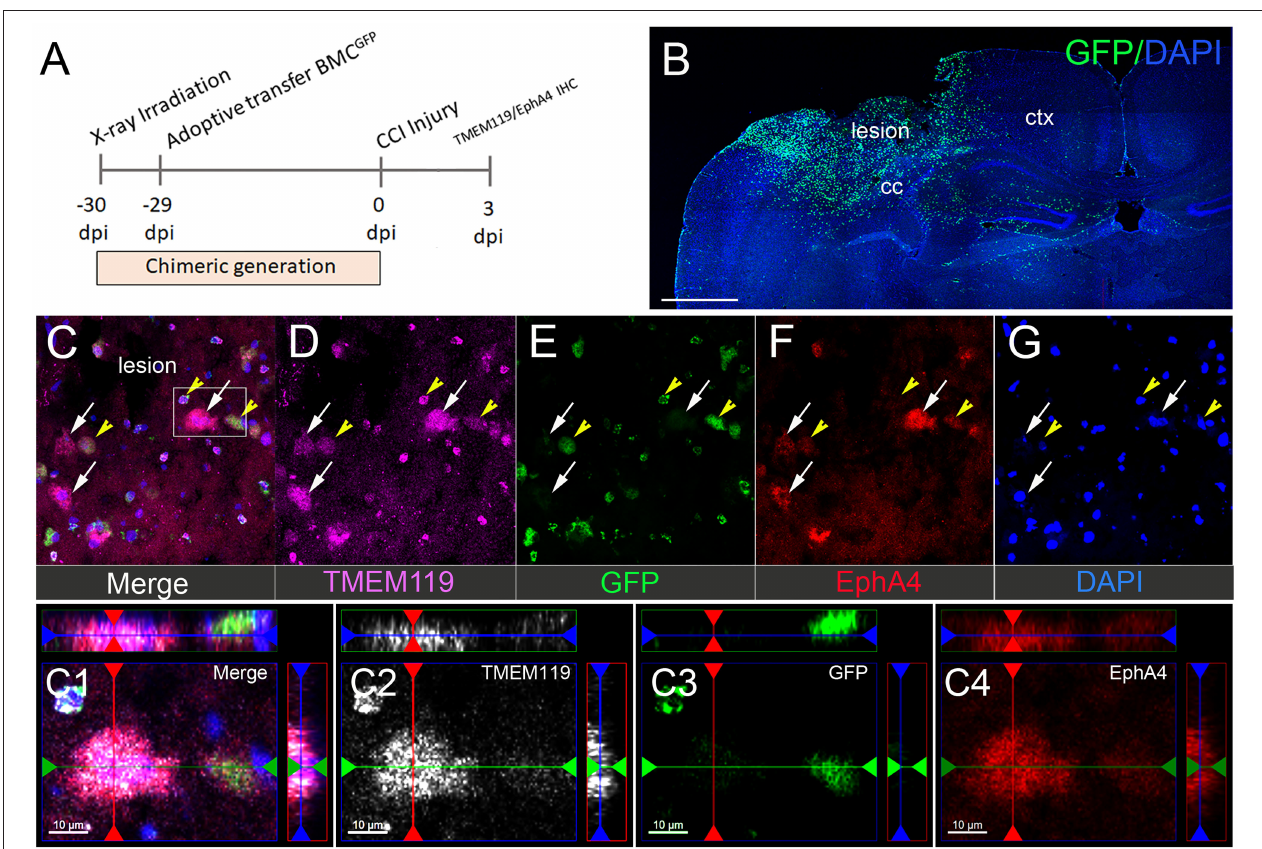
FIGURE 2 | Microglial EphA4 is upregulated in the damaged cortex after CCI injury. (A) Timeline for generation of GFP bone marrow chimeric mice and CCI injury. Mice were euthanized 3 dpi, and brain sections were used for IHC analysis of TMEM119 and EphA4. (B) Representative confocal images for peripheral-derived immune cells (GFP), infiltrating the ipsilateral injured cortex. (C–G) Representative images of TMEM119 (purple) and EphA4 (red). EphA4 is expressed on amoeboid-resident microglia (white arrow, EphA4 + /GFP − /TMEM119 + ) as well as peripheral-derived GFP immune cells, which also express TMEM119 (yellow arrowhead, EphA4 + /GFP + /TMEM119 + ). (C1–C4) Representative images showing the colocalization of TMEM119 (white) and EphA4 (red) in GFP − microglia. Scale bar in (B) 1,000 µ m; (C1–C4) 10 µ